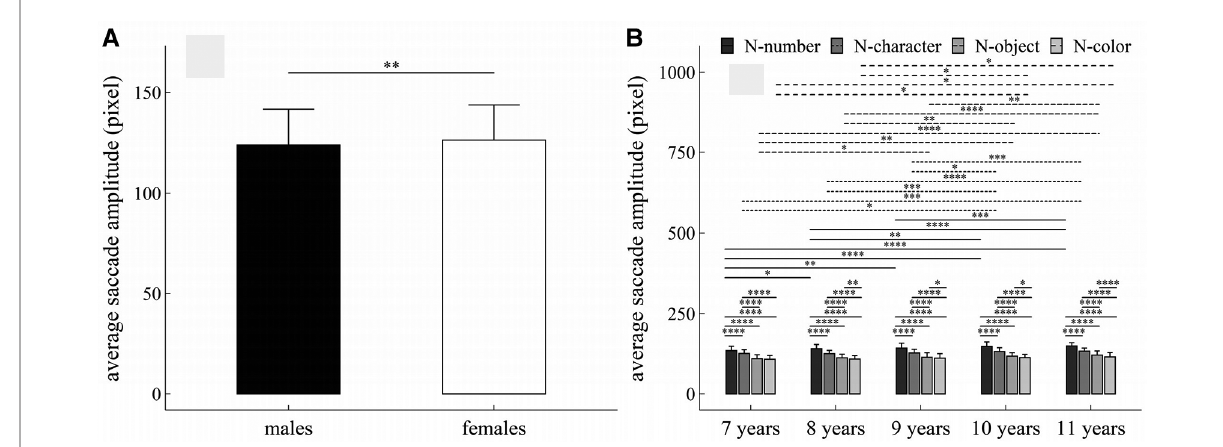
FIGURE 6 In fl uence of task-type, gender and age on average saccade amplitude: ( A ) in fl uence of gender; ( B ) interactive effect of age and task-type. * p <0.05; ** p <0.01; *** p <0.001; **** p